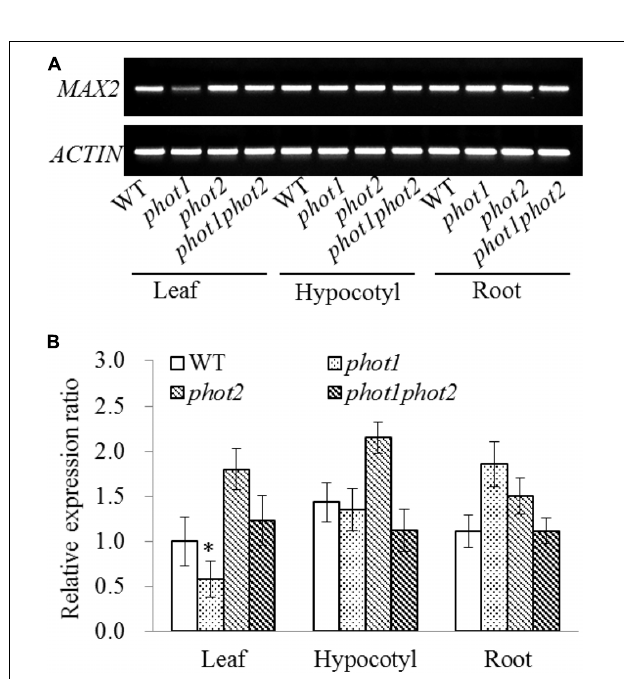
FIGURE 7 | Gene expression of MAX2 in the WT and phot mutants by RT-PCR and qRT-PCR. (A) RT-PCR analysis of MAX2 gene expression levels in the leaves, hypocotyls, and roots of 7-day-old WT, phot1 , phot2, and phot1 phot2 plants. (B) Expression of MAX2 in the leaves, hypocotyls, and roots of 7-day-old WT, phot1 , phot2, and phot1 phot2 plants, determined using quantitative real-time PCR (qRT-PCR). Values are the means of three biological repeats ± SD. ∗ P <